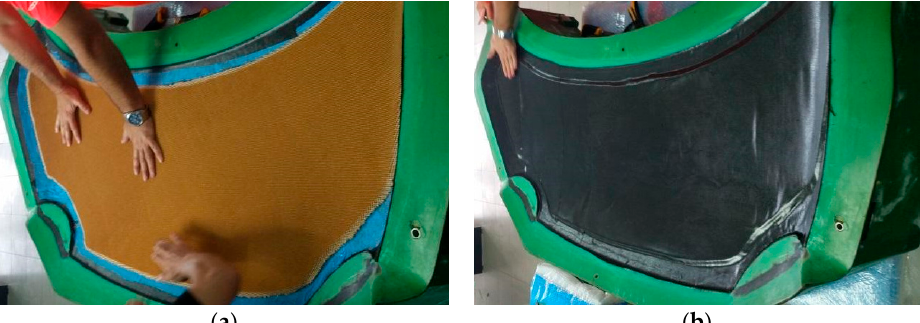
Figure 7. Sandwich structure manufacturing: ( a ) Nomex Honeycomb applied on CRFP layers; ( b ) covering of Nomex Honeycomb with CFRP prepreg.